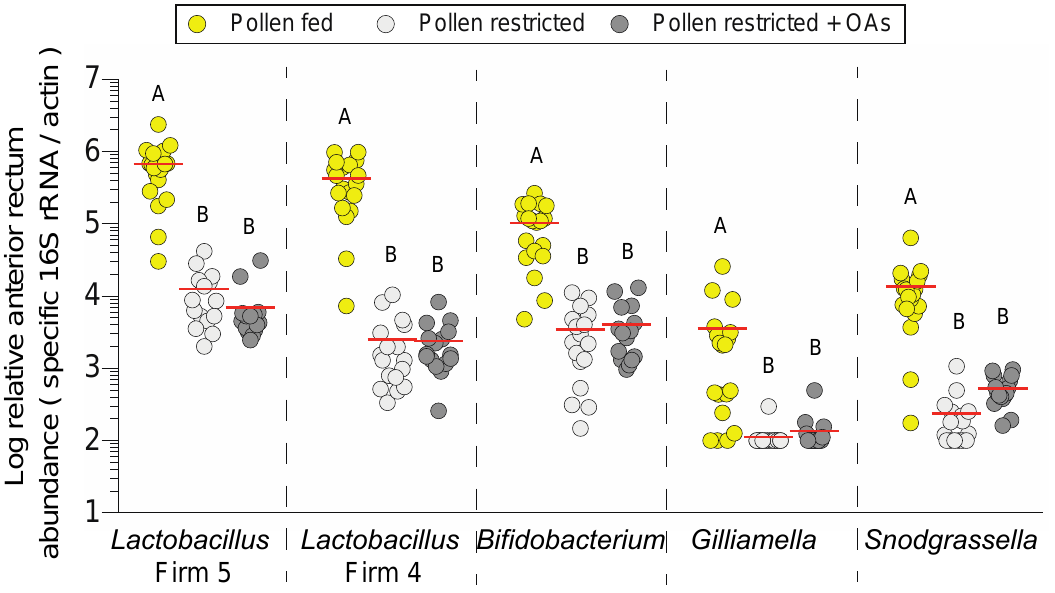
Figure 3. Relative anterior rectum species-specific 16S rRNA abundance in honey bees subjected to different diet treatments (pollen-fed, pollen restricted, pollen restricted + organic acids (OAs)). Each point represents a pooled sample from an independent cage ( n = 16–19 cages). Black horizontal lines indicate the mean. Different letters indicate Tukey HSD P < 0.05.